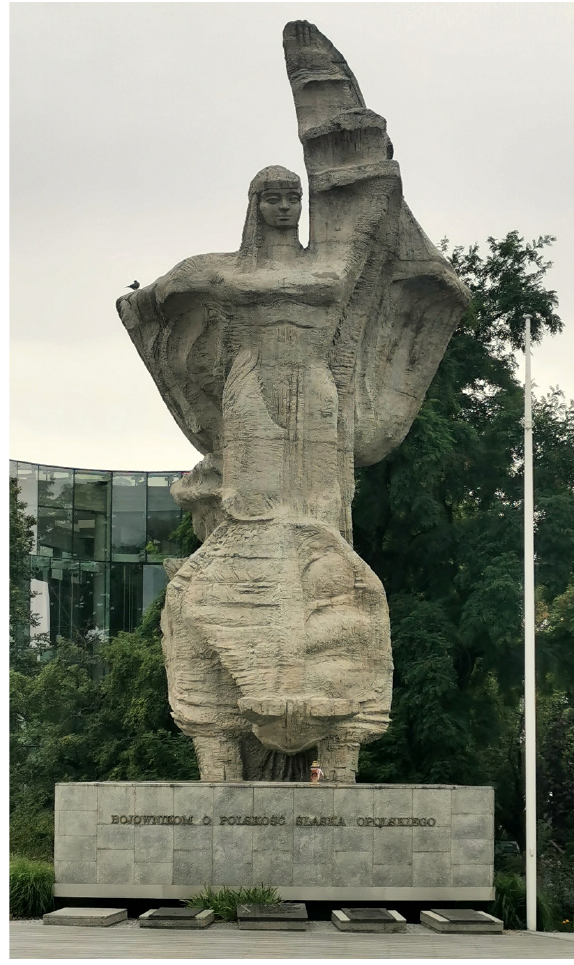
Figure 6. Monument to the Opole Silesian fighters for